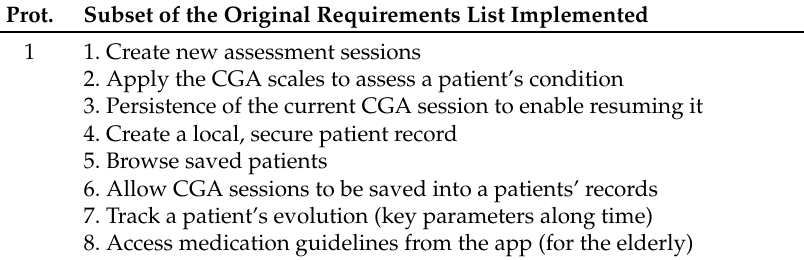
Table 3. Requirements considered along the iterative development of Geriatric Helper, for each iteration